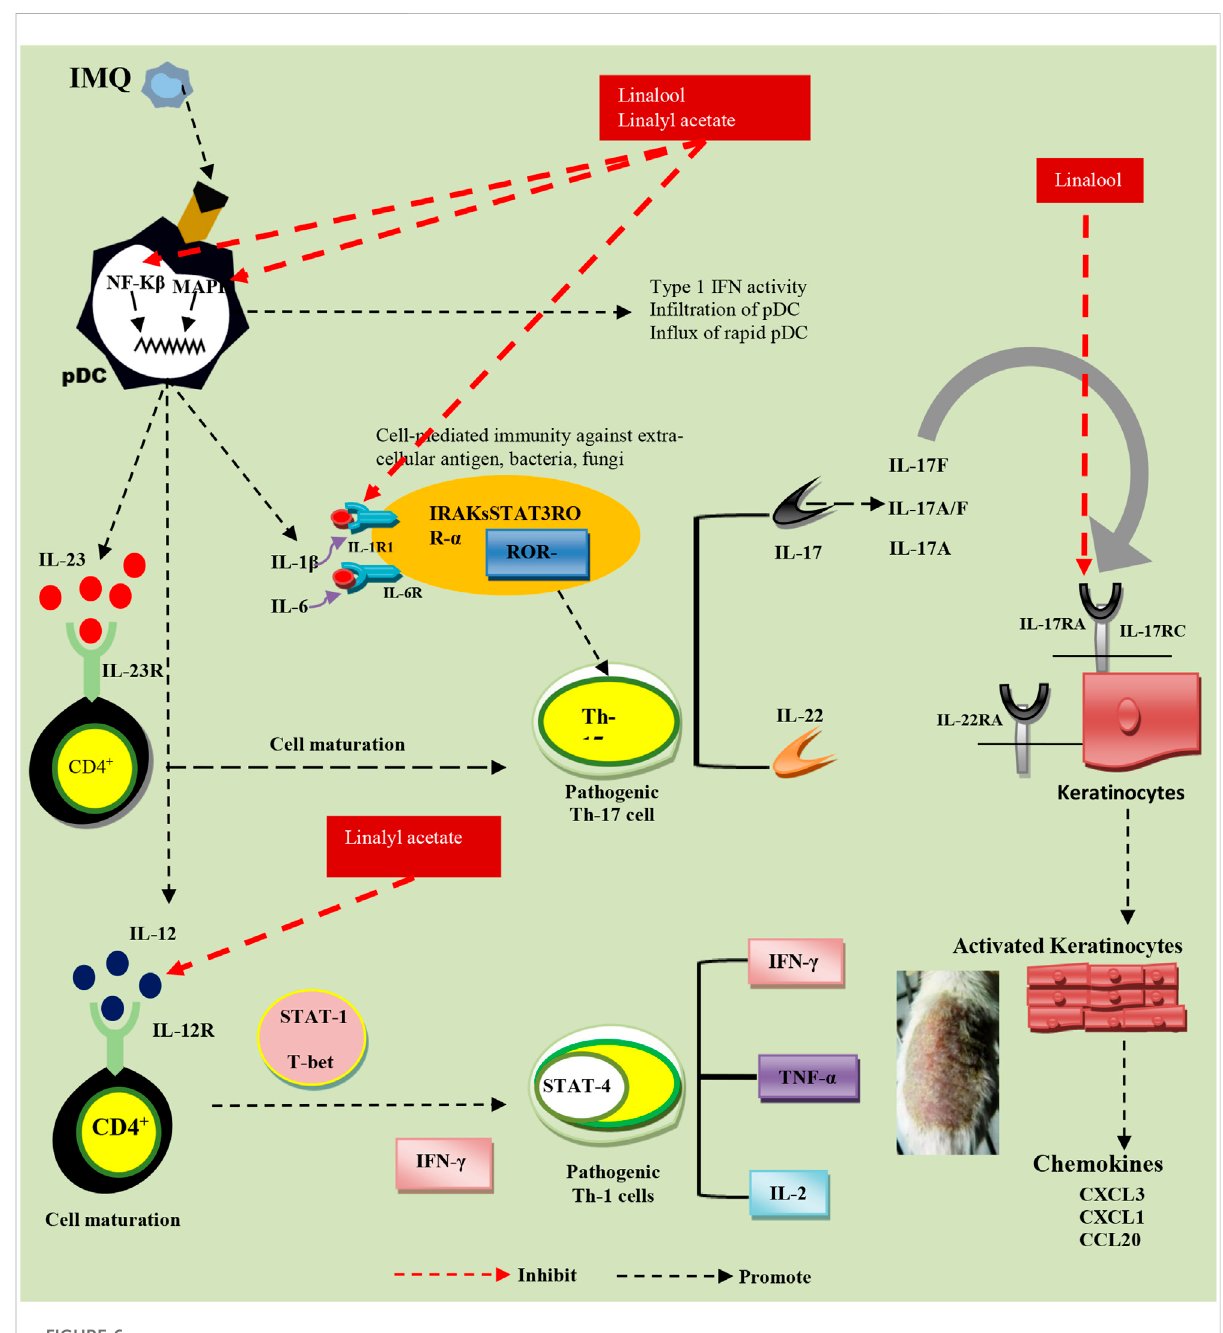
FIGURE 6 Probable pathways of linalool and linalyl acetate effectiveness against IMQ-induced psoriasis.